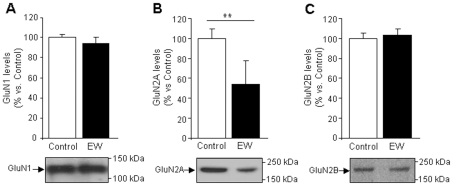
Ethanol withdrawal (EW) decreases GluN2A subunit levels.NMDA subunit protein levels measured by Western blot analysis: GluN2A levels (B) decrease during ethanol withdrawal, whereas the levels of GluN1 (A) and GluN2B (C) remain unaltered. Values are expressed as percentages over control data for each subunit and are means ± SEM (n = 3–5 samples/condition). Data were assessed by the t-Student's test (**P<0.01 vs. control).